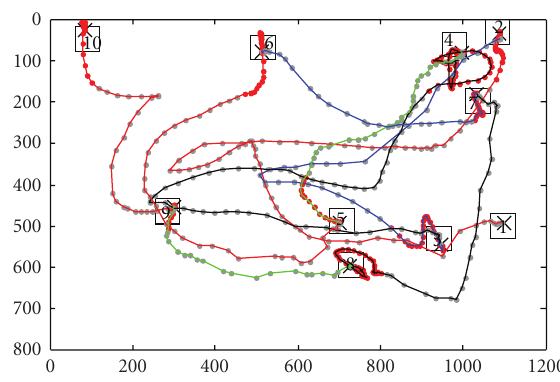
Figure 12: A search path using halo&zoom in the plane.